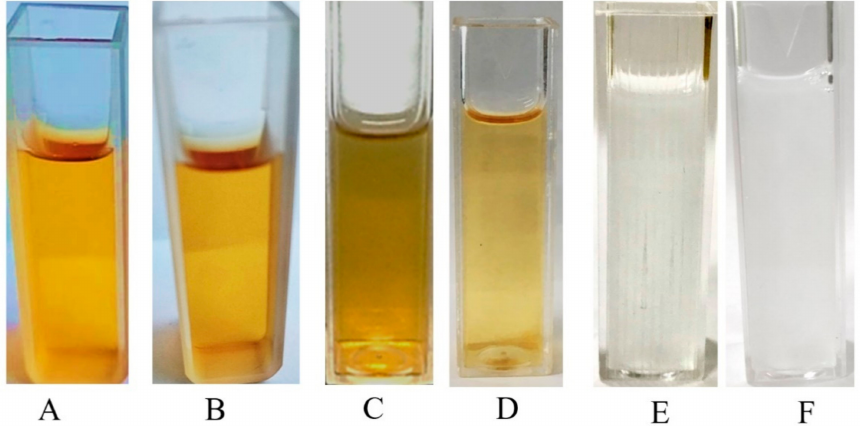
Figure 1. Images of silver nanoparticle (AgNP) solutions produced by ( A ) process A + 1 mM AgNO 3 , ( B ) process A + 2 mM AgNO 3 , ( C ) process B + 1 mM AgNO 3 , ( D ) process B + 2 mM AgNO 3 , ( E ) process C + 1 mM AgNO 3 and ( F ) process C + 2 mM AgNO 3